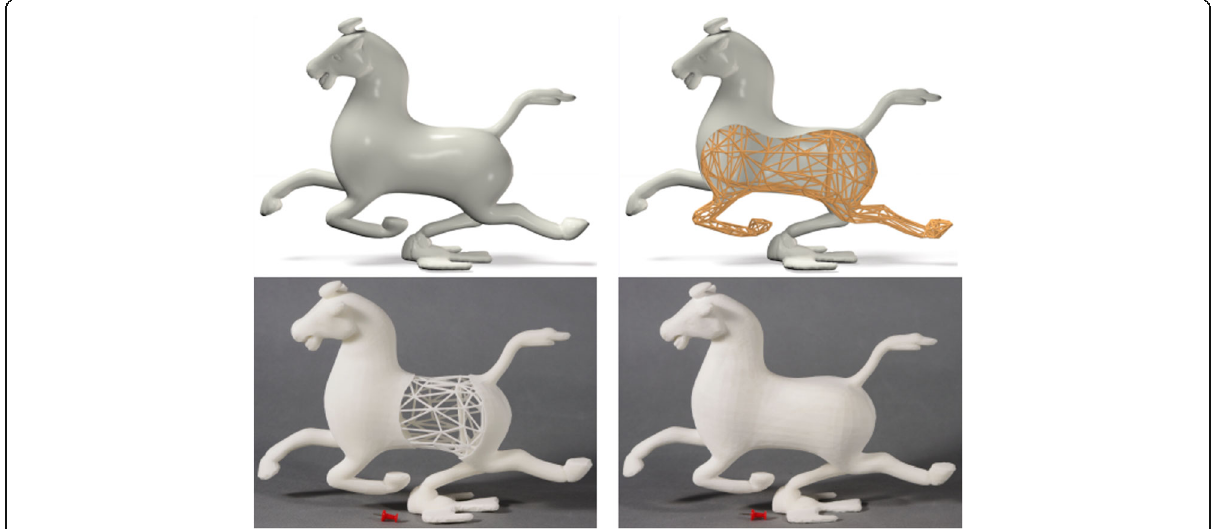
Fig. 1 Skin-Frame lightweight structure design and manufacturing results by 3D printing [16]